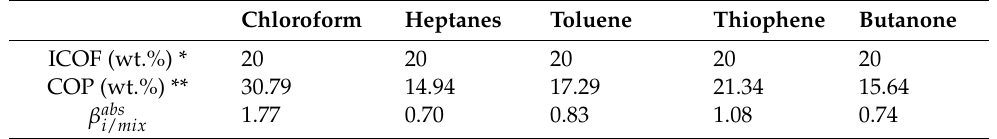
Table 12. Starting composition of the organic mixture in the feed, that in the permeate and the selective absorption of the membrane factor during the 1.5 h extraction process. Chloroform Heptanes Toluene Thiophene Butanone ICOF (wt.%) * 20 20 20 20 20 COP (wt.%) ** 30.79 14.94 17.29 21.34 15.64 β abs i / mix